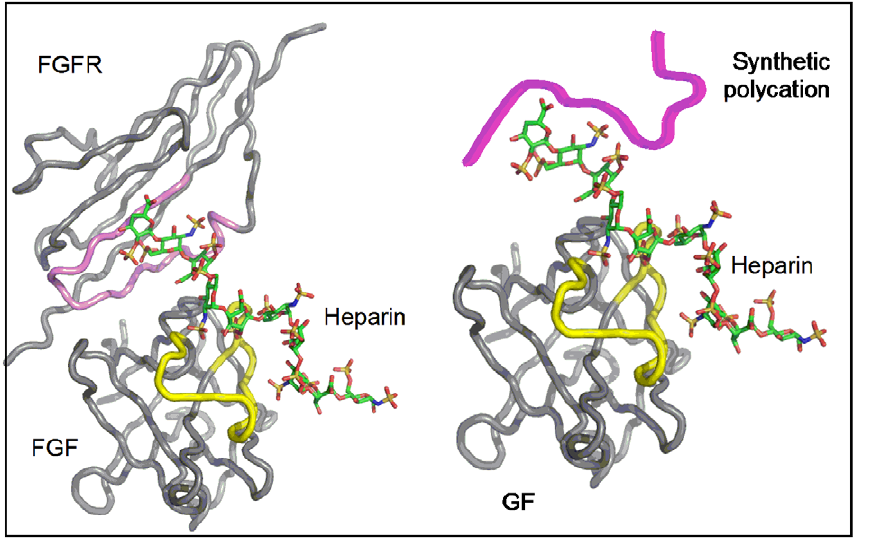
Figure 1. Our delivery strategy was inspired by the interaction among growth factor, heparin and growth factor receptor. Left , the crystal structure of the [FGF:Heparin:FGFR] complex kindly provided by Dr. Pellegrini. The proteins are shown as coils and heparin as a stick model. The heparin-binding domains of FGFR and FGF are highlighted in pink and yellow respectively. Both analyses showed that the heparin-binding regions contain a high density of positively charged amino acid residues such as arginine. Right , a possible model of the matrix formed by ionic interactions between an arginine-based synthetic polycation and a [heparin:growth factor] complex.